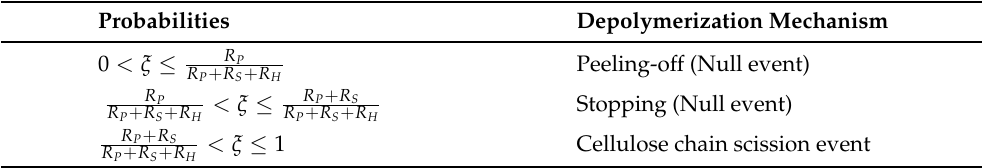
Table 1. Probability distribution for cellulose